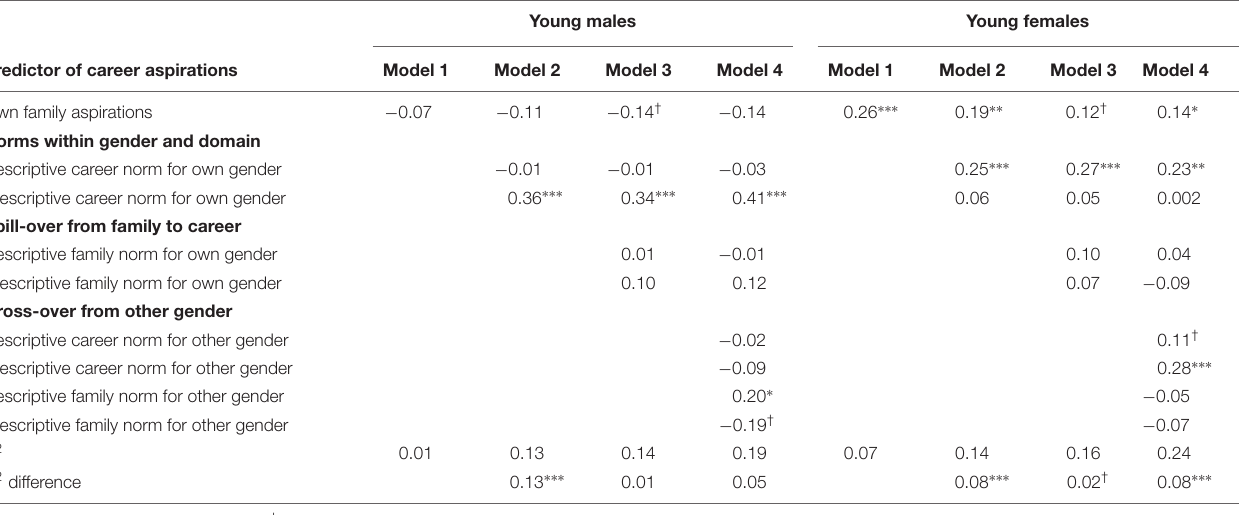
TABLE 3 | Hierarchical regression models predicting young male and female participants’ career aspirations from different gender norms (standardized coefficients).